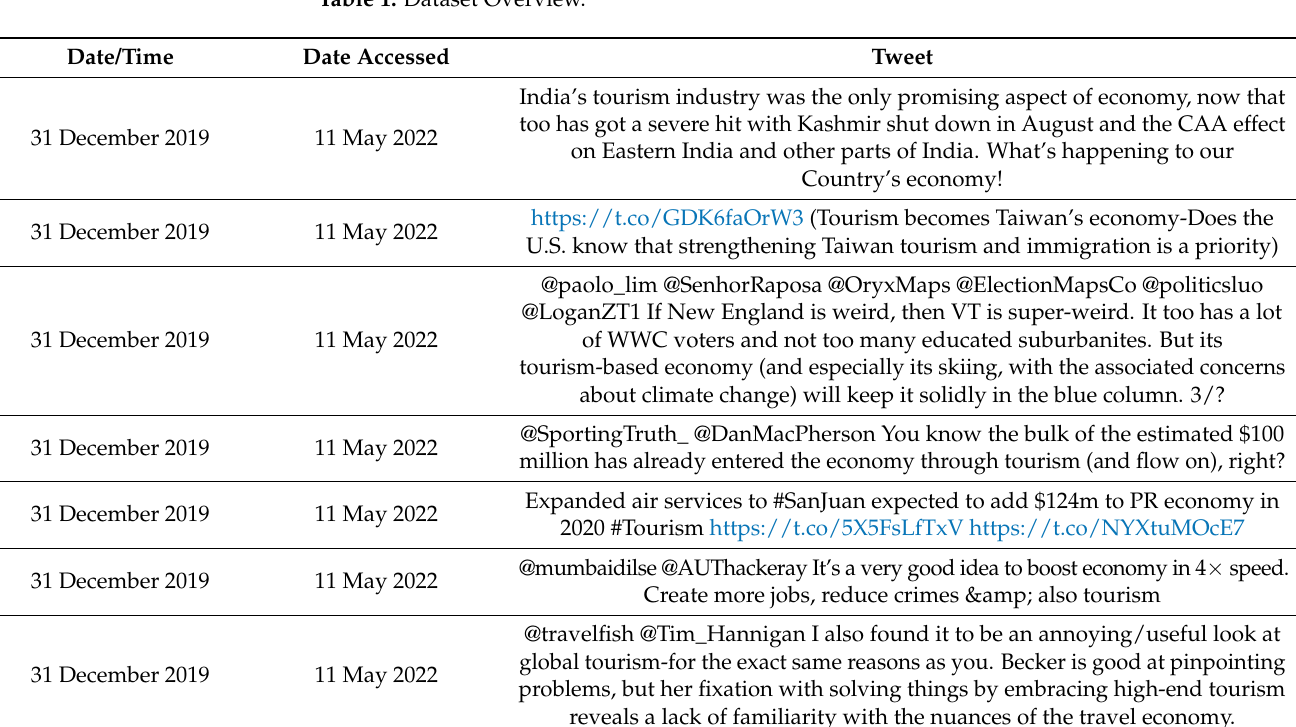
Figure 1. Methodology Overview. Table 1. Dataset